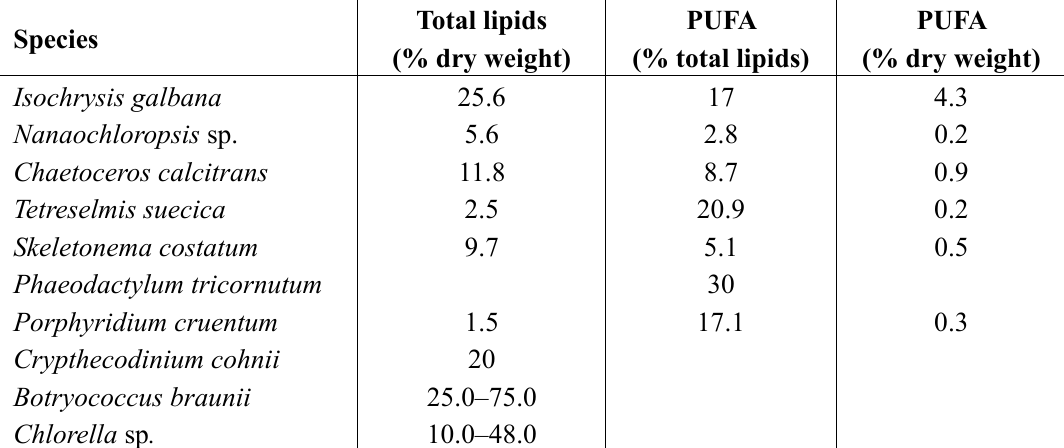
Table 3. Examples of lipid contents in some microalgae species [4,48]. Species